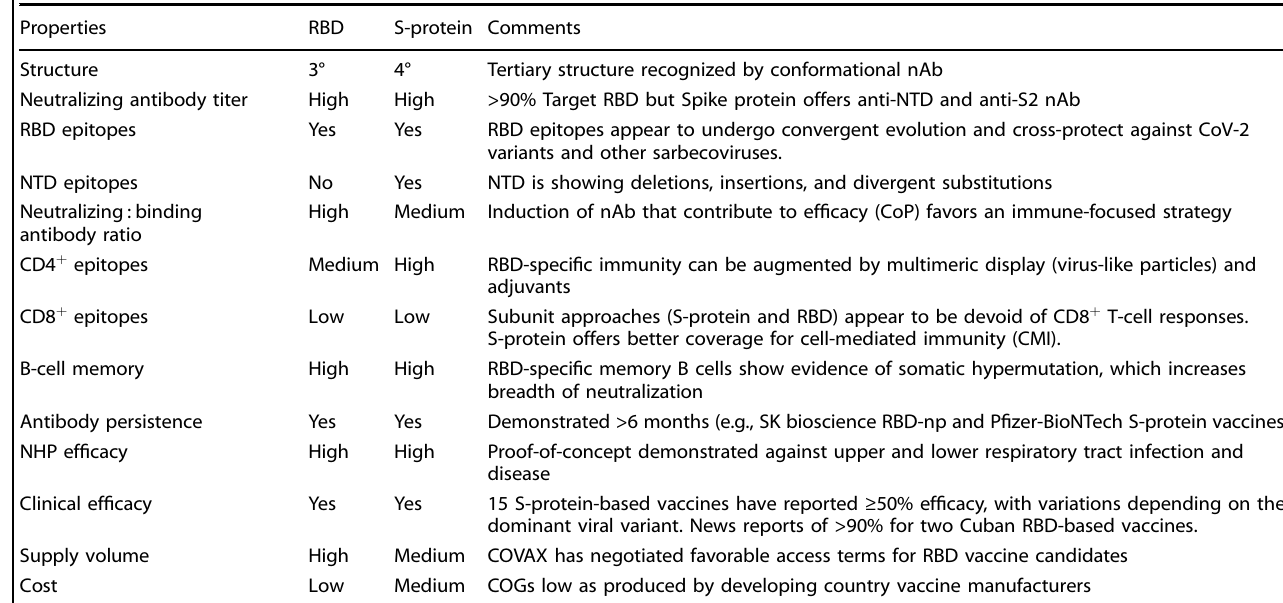
Table 1. Properties of RBD-based vaccine immunogens compared to full-length S-protein